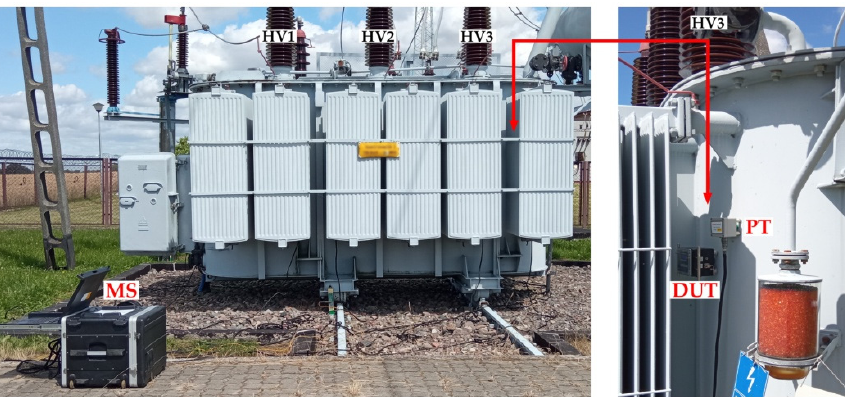
Figure 13. Monitoring of partial discharges in the HV3 phase of a 10 MVA power transformer: MS—reference monitoring system PDtracker Portable; PT—piezoelectric transducer of the reference monitoring system; DUT—tested low-cost PD monitoring system.